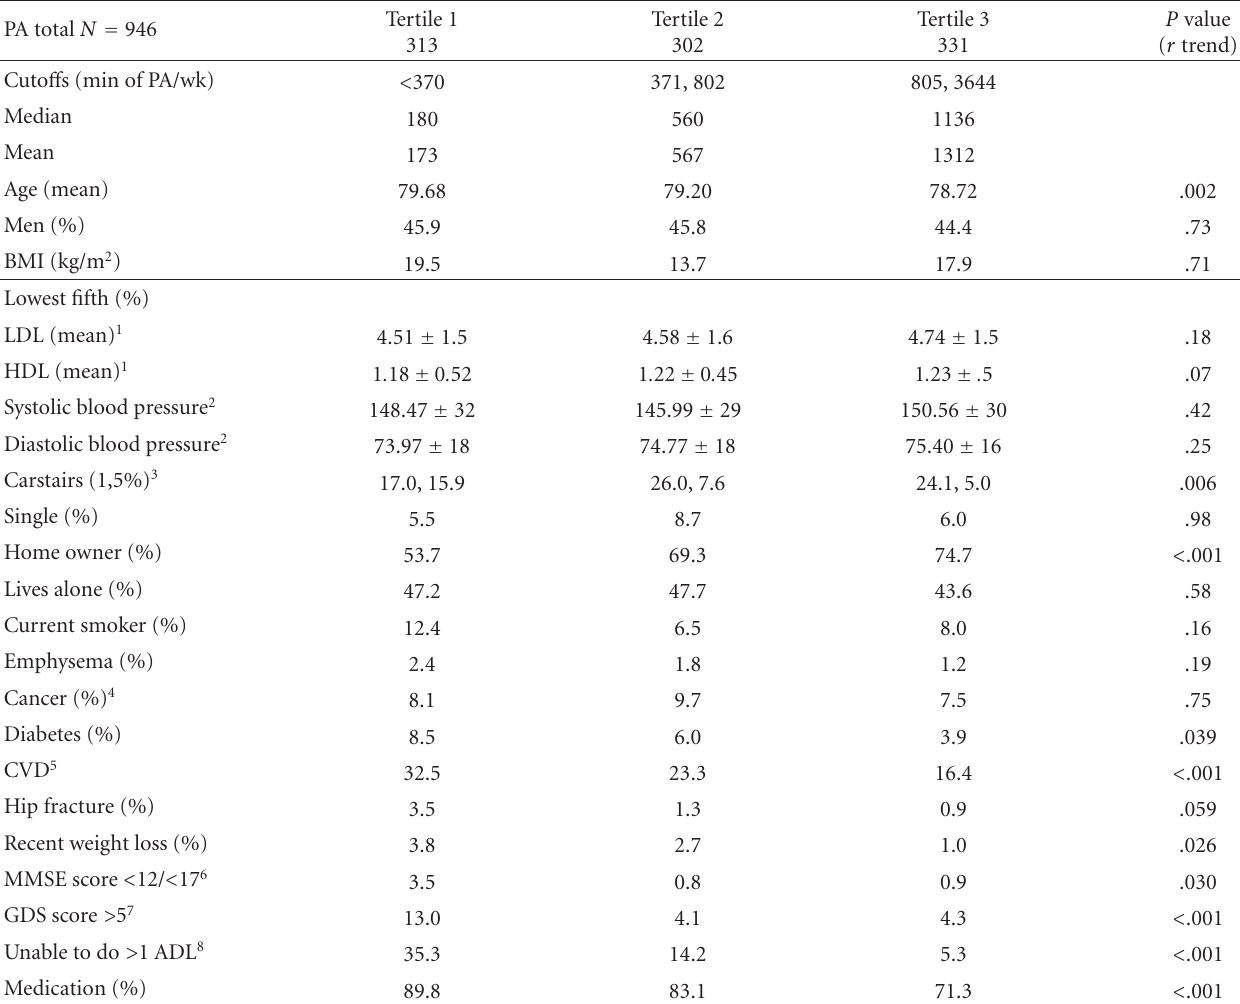
Table 3: Characteristics of the study participants by tertile of total duration of PA